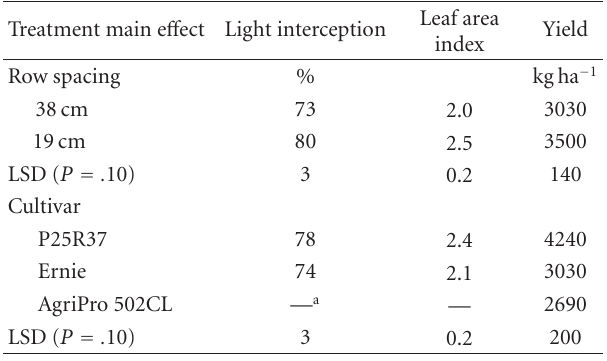
Table 4: Wheat light interception, leaf area index, and grain yield for row spacing and cultivar main e ff ects. Data were averaged over